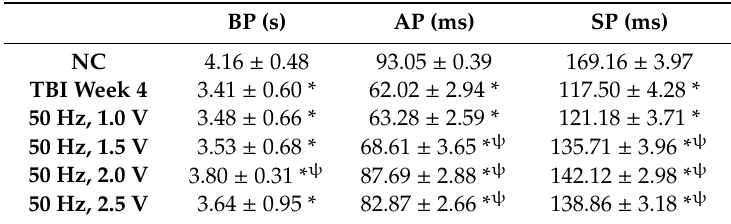
Table 2. External urethral sphincter electromyographic (EUS-EMG) activity in normal control (NC), traumatic brain injury (TBI), and TBI-deep brain stimulation (DBS) rats treated with pedunculopontine tegmental nucleus deep brain stimulation (PPTg-DBS) at di ff erent voltages. BP, burst period; AP, active period; SP, silent period. * Indicates a significant difference compared to BP (s) the NC group; ψ Indicates a significant difference compared to TBI rats (week 4). The frequency of